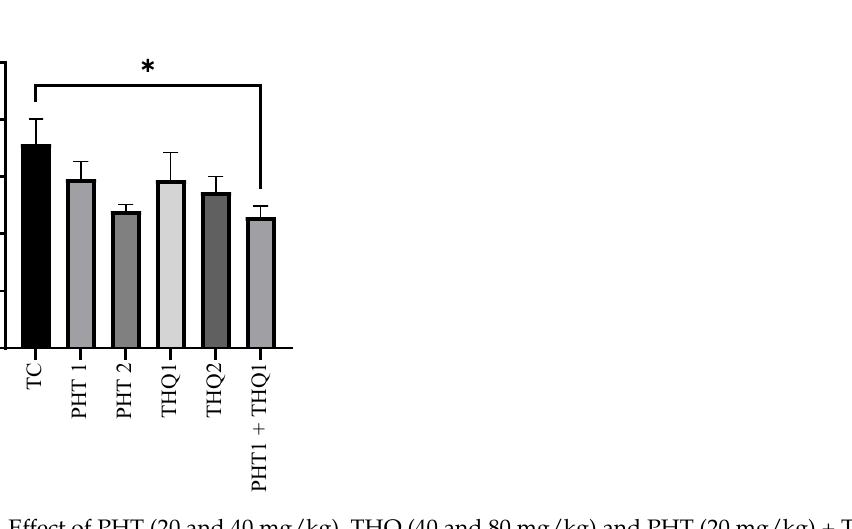
Figure 2. Effect of PHT (20 and 40 mg/kg), THQ (40 and 80 mg/kg) and PHT (20 mg/kg) + THQ (40 mg/kg) on recovery time following MES-induced convulsions in rats. One-way ANOVA followed by Dunnet’s test was used to compare quantitative variables from the toxic control vs. other groups. PHT, THQ, TC and MES indicate phenytoin, thymoquinone, toxic control and maximal electric shock, respectively. * p < 0.05. MES (180 mA, 220 V for 0.20 s) produced a substantial rise ( p < 0.001) in hippocampal mTOR levels in the toxic control group, compared to normal control. PHT (40 mg/kg) and THQ (40 and 80 mg/kg) reduced ( p < 0.05, p < 0.05, p < 0.01) mTOR levels, respectively. How- ever, the most marked reduction ( p < 0.001) of m-TOR levels was exhibited by the low dose combination regimen of PHT (20 mg/kg) and THQ (40 mg/kg). All treated groups were com- pared with toxic control group. The results indicate hyperactivation of the m-TOR pathway in epileptic states, resulting in hyperexcitability and epileptogenesis, which seem to be re- stricted by the synergistic combination of PHT and THQ (at low doses) (Figure 3).